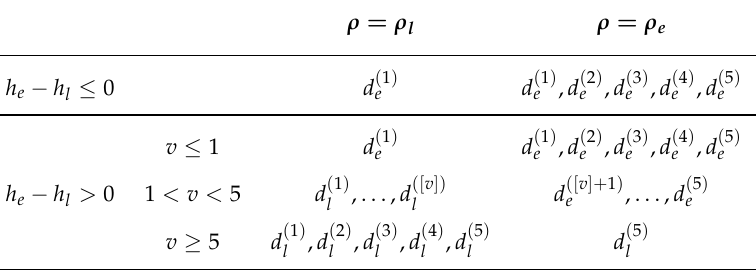
Table 3. Optimal solutions to Problem 1 for ρ = ρ l and ρ = ρ e